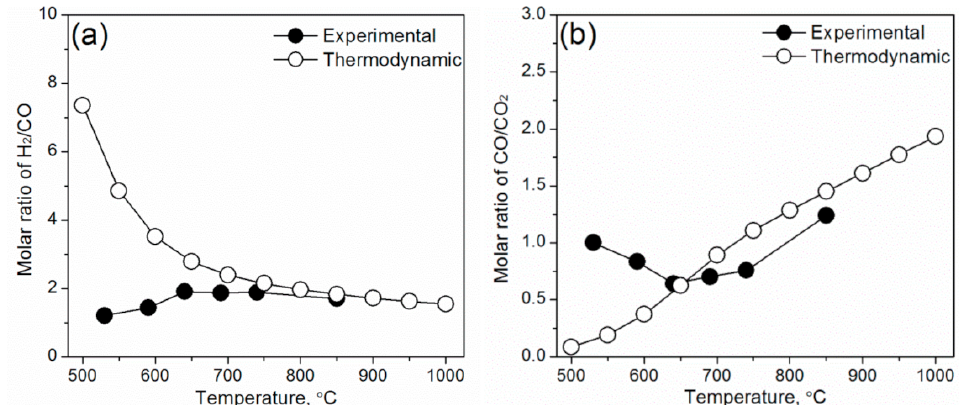
Figure 4. Comparison of ( a ) overall H 2 /CO ratio and ( b ) CO/CO 2 ratio between experimental results and thermodynamic equilibrium calculation during the SCR of bio-syngas with 40 vol % steam